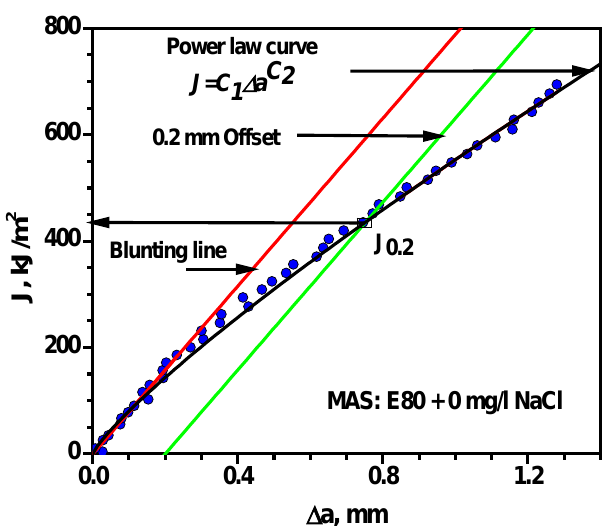
Figure 11. Identification of critical fracture toughness ( J 0.2 ) on the J - R curve obtained from MAS specimen.